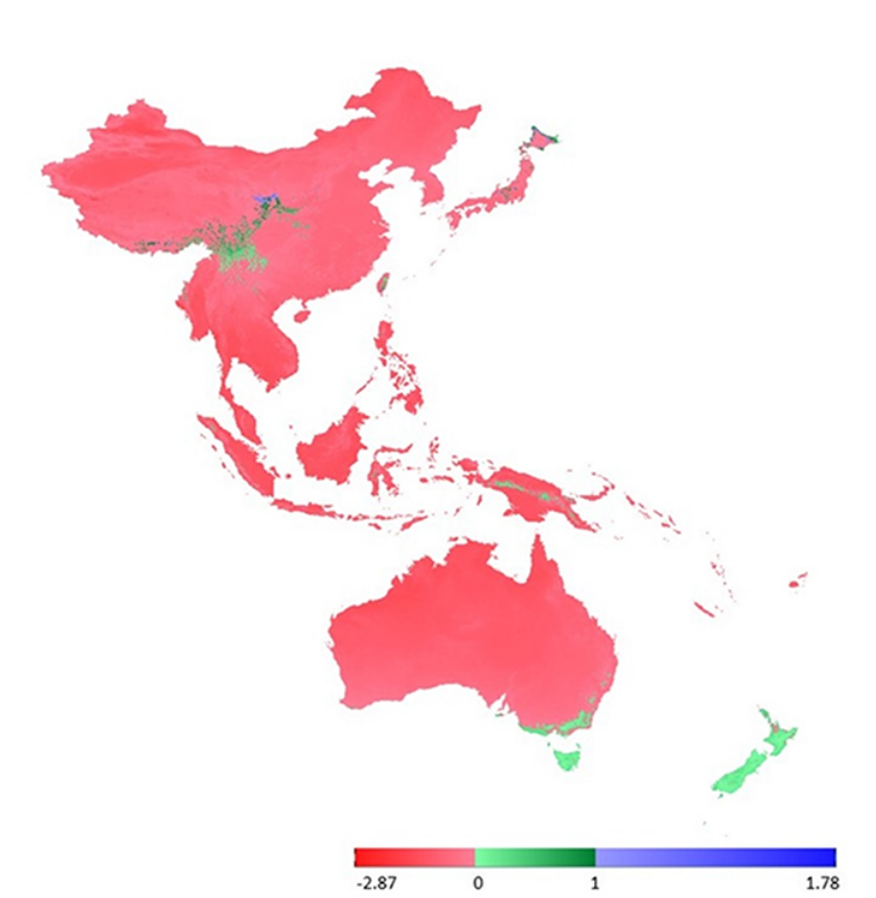
Figure 4 ExDet map showing the quantification of extrapolated projection areas for Lewinskya graphiomitria based on the first set of variables (BIO5, BIO6, and BIO13). No extrapolation (green), type 1 novelty (red), and type 2 novelty (blue).